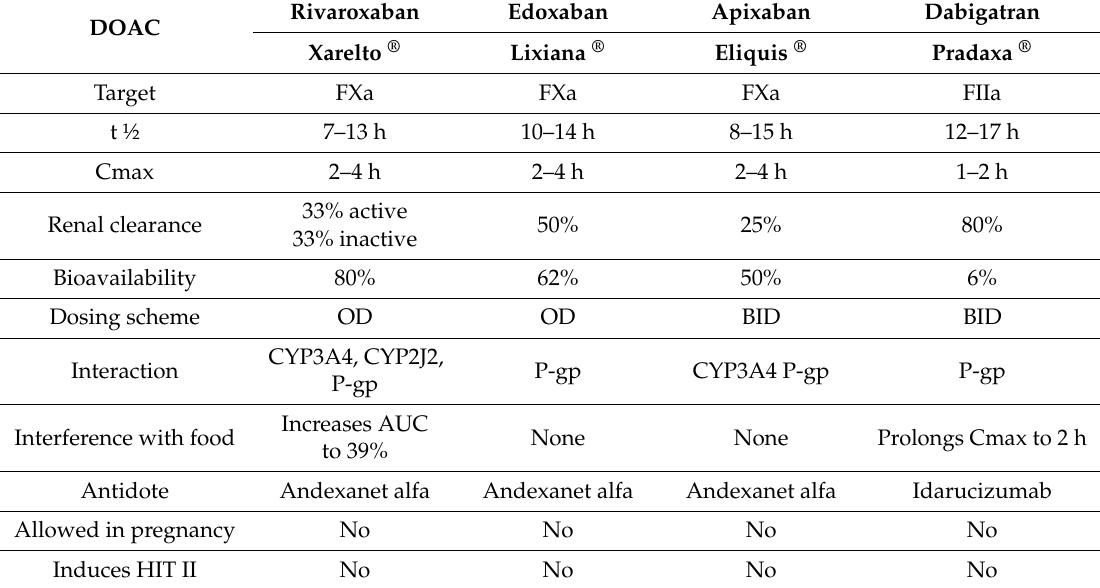
Table 1. Pharmacodynamics and pharmacokinetics of DOAC (once daily (OD); twice daily (BID); P-glycoprotein (P-gp); area under the curve (AUC); heparin induced thrombocytopenia (HIT); maximum drug concentration in plasma